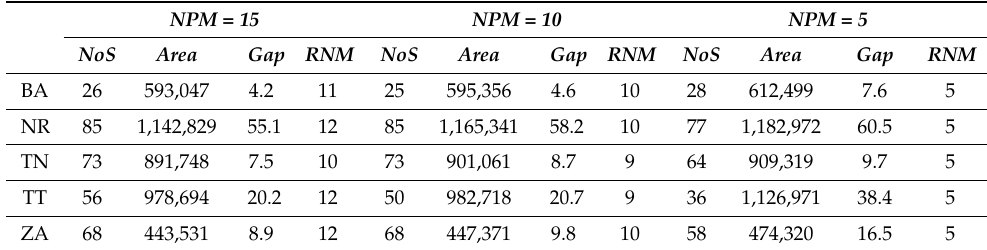
Table 3. Summary of results obtained for selected self-governing regions of Slovakia—part 2.